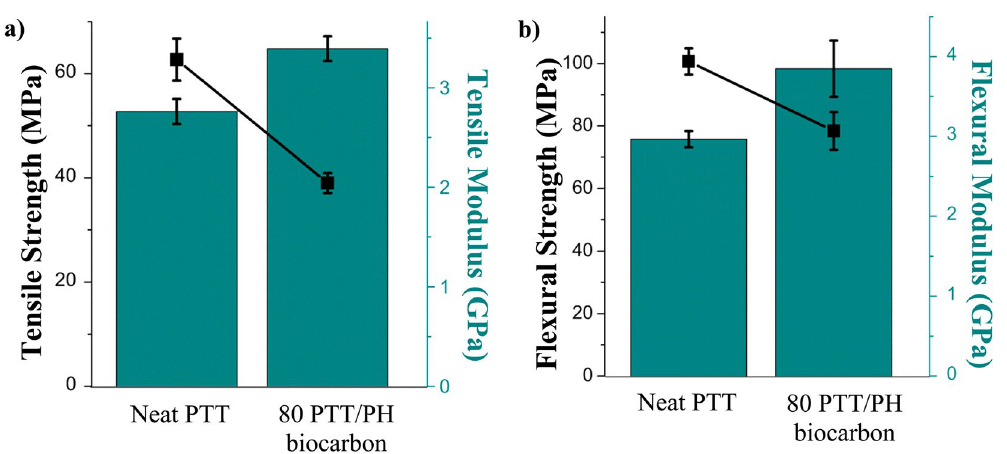
Figure 9. ( a ) tensile properties and ( b ) flexural properties for neat PTT and 500 °C PH biocarbon composite